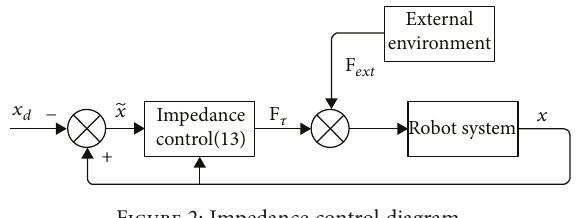
Figure 2: Impedance control